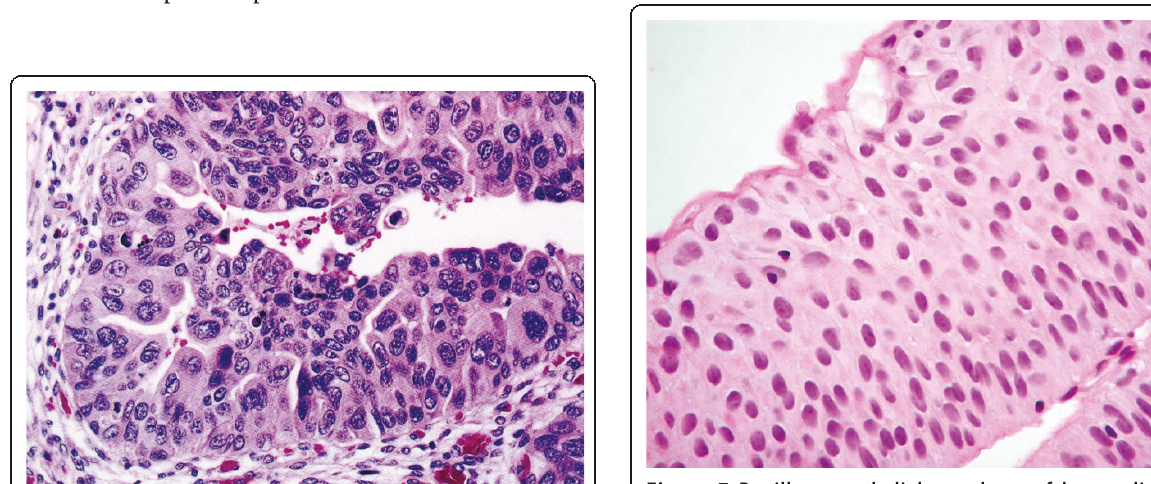
Figure 7 Papillary urothelial neoplasm of low malignant potential